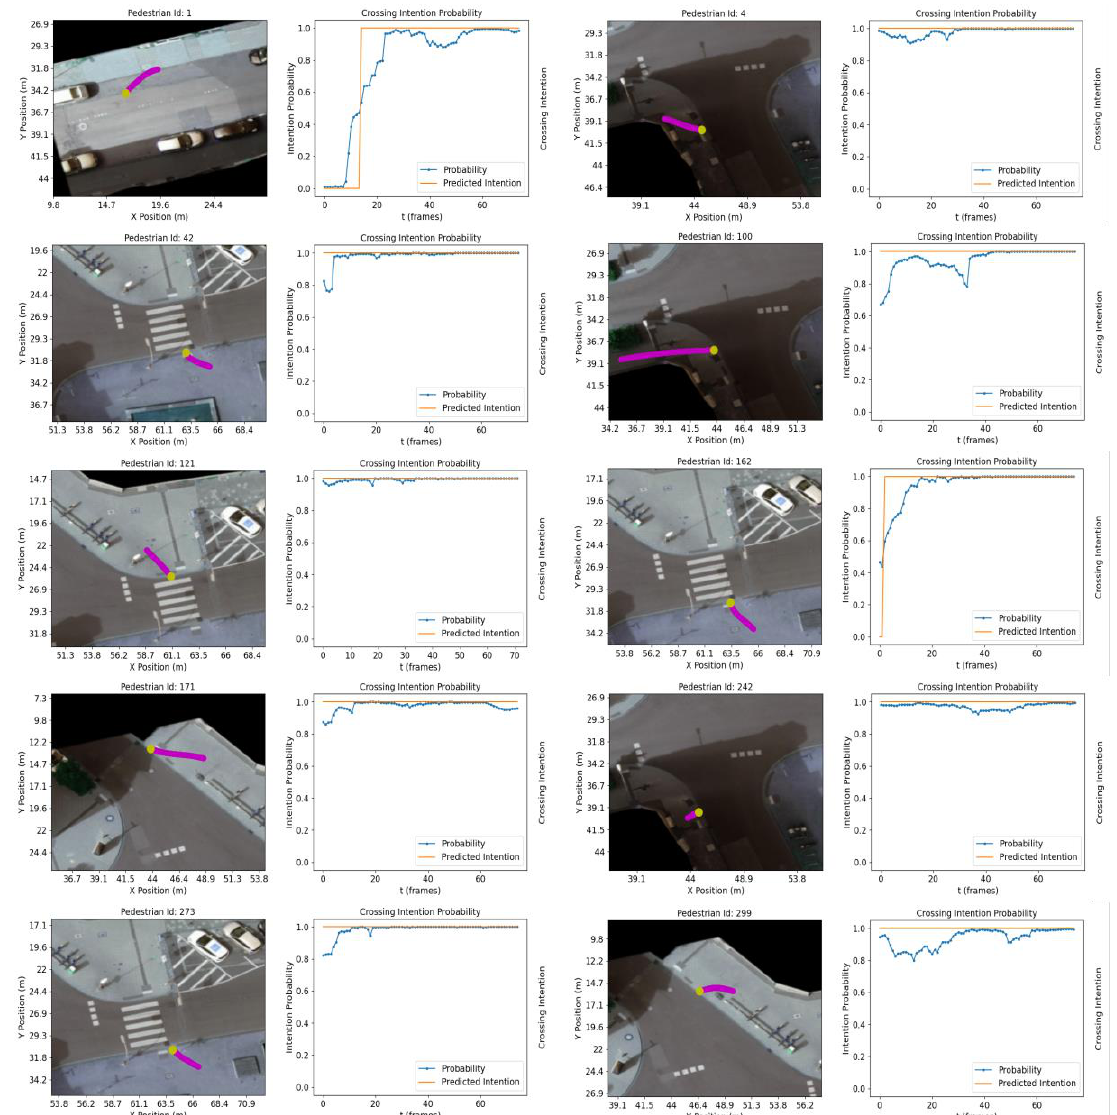
Figure 5. Classification results for 10 crossing trajectories. Pedestrian trajectories are shown in magenta. The trajectory point shown in yellow indicates the last trajectory sample in the sequence.